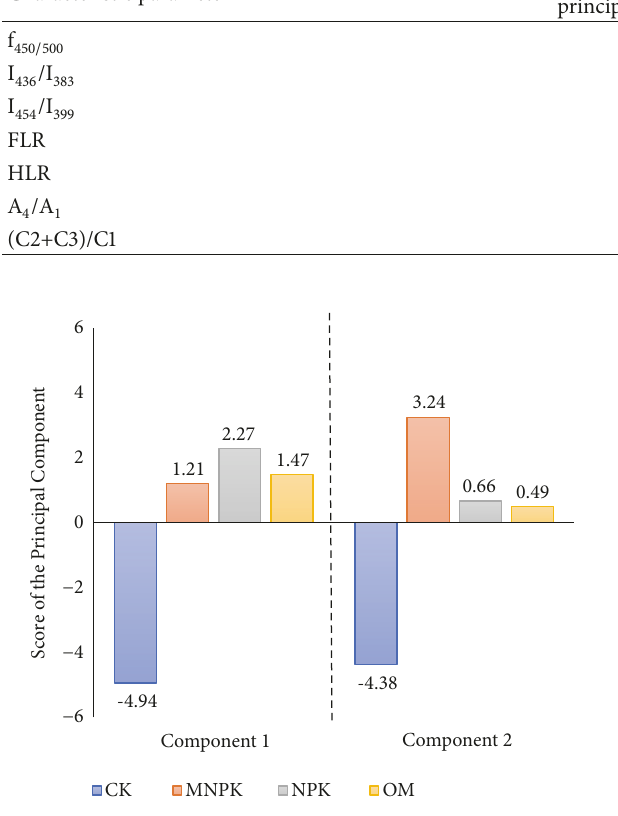
Figure 3: Scores of the first two principal components for dif- ferent treatments. CK=control, NPK= NPK fertilizer, OM=organic manure, and MNPK=manure +